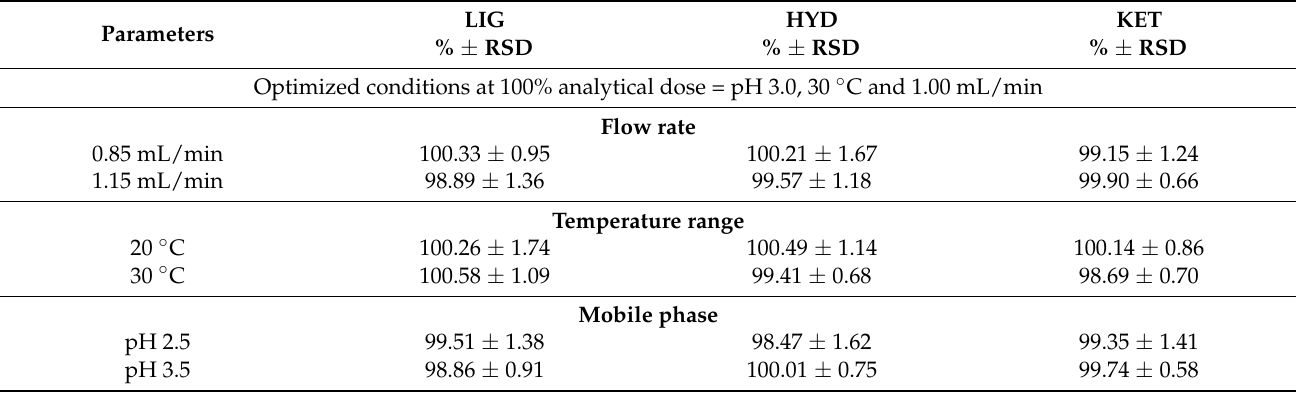
Table 5. Outcome of robustness of the proposed